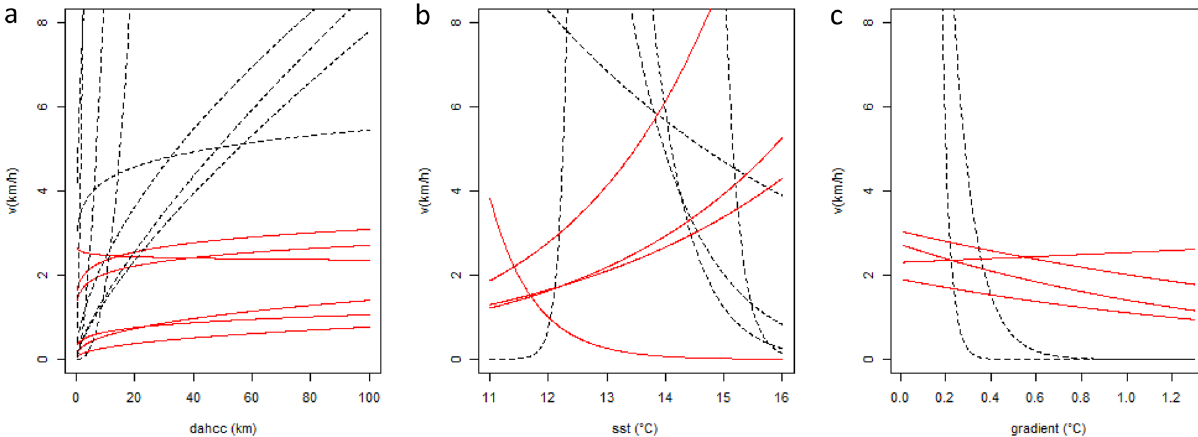
Figure 3. Prediction curves indicate expected variation in long-term velocity ( ν t ) in relation to environmental covariates, ( a ) distance to areas of high chlorophyll concentration (DAHCC) in log scale, ( b ) sea surface temperature (SST) and c) thermal gradients. Red lines indicate predictions for whales exhibiting more than 200 locations (ID#s 5, 7, 11, 12, 13, 14 and 15) and black lines correspond to those with less locations available.